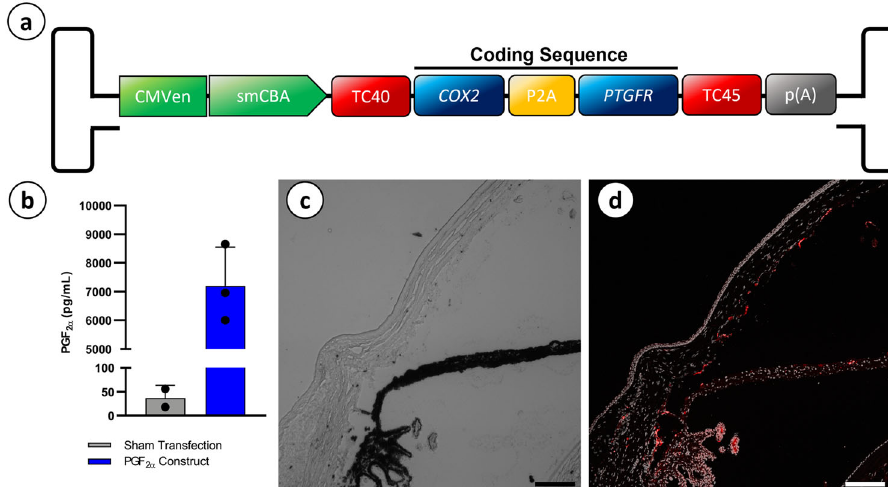
Fig. 1 Construct schematic and con fi rmation of in vitro activity and in vivo tropism. A diagrammatical representation of the CCPP transgene driven by a CMV enhancer and smCBA promotor while containing two tetracycline off-type riboswitches (TC40 and TC45), as well as human codon optimized COX2 and PTGFR separated by a P2A cleavage signal ( a ). A PGF 2 ɑ ELISA con fi rmed signi fi cantly higher concentrations of PGF 2 ɑ in cell culture media after transfection with CCPP transgene than media collected from sham transfected cells ( b ) (unpaired T-test, p = 0.0056, N = 2 (sham transfected) N = 3 (CCPP transfected), error bars = SD). Bright fi eld and fl uorescent imaging of rAAV2/2[MAX]-smCBA-mCherry eyes 8-weeks post injection con fi rm vector tropism within the iris, corneal endothelium, and ciliary body ( c , d ). Scale bar = 150 µ m, Magni fi cation =